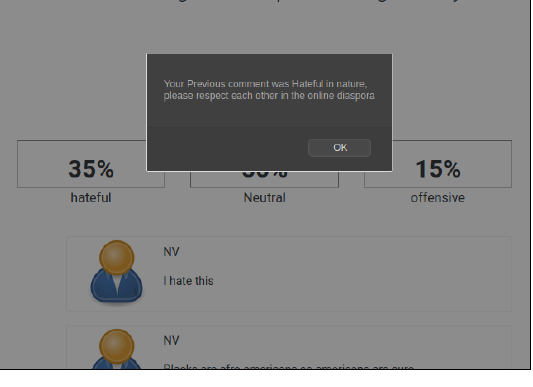
Figure 6. Proactively notifying users that their comment is hateful in